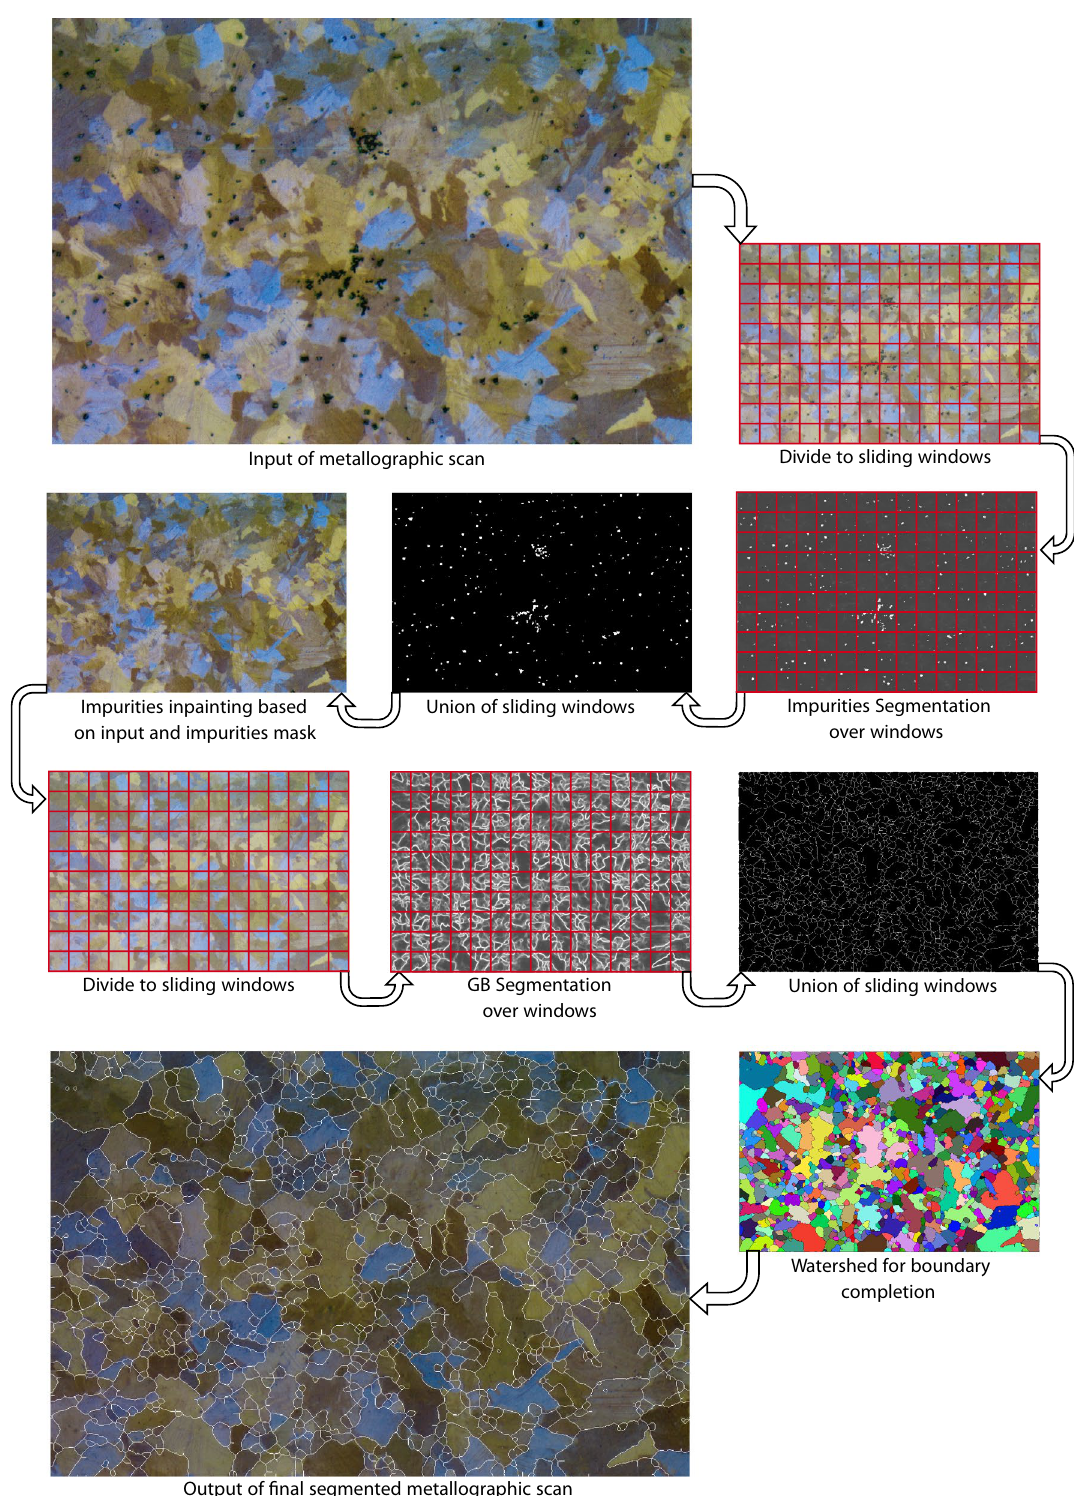
Figure 1. Proposed segmentation pipeline. This pipeline serves, in part, as the data pre-processing to the anomaly detection